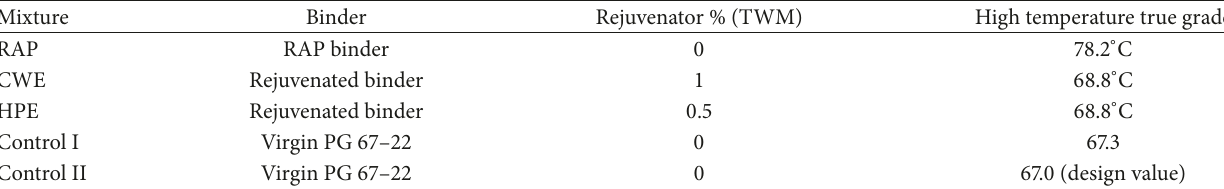
Table 2: Rejuvenator percentage and high temperature grades of samples.